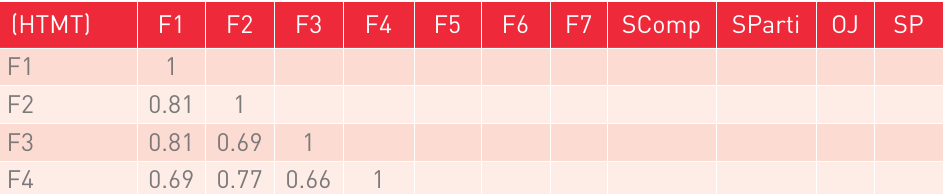
Discriminant validity for the structural model in